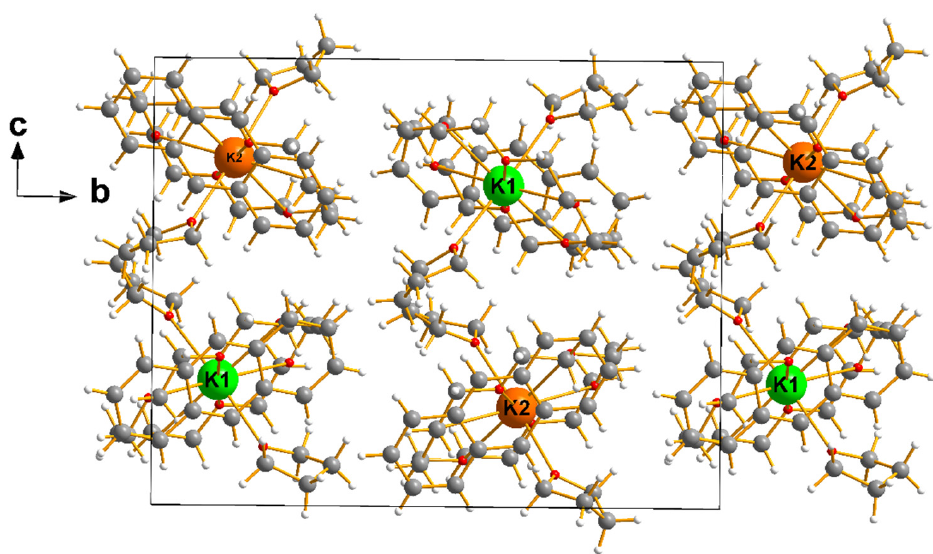
Figure 5. This is the best orientation (down the a -axis) to show the contents of the unit cell. The oxygen atoms of the axial furan ligands appear as red dots bound to the potassium cations by an orange-colored bond. With the help of Figure 4, one can better understand the relationships between the moieties constituting the crystal’s asymmetric unit. The cation–anion pair constituting the asymmetric unit are nearly identical, as is characteristic of kryptoracemic crystals. Therefore, we show one such pair in Figure 6, in order to illustrate the cation–anion stereochemical relationships present in an asymmetric unit.